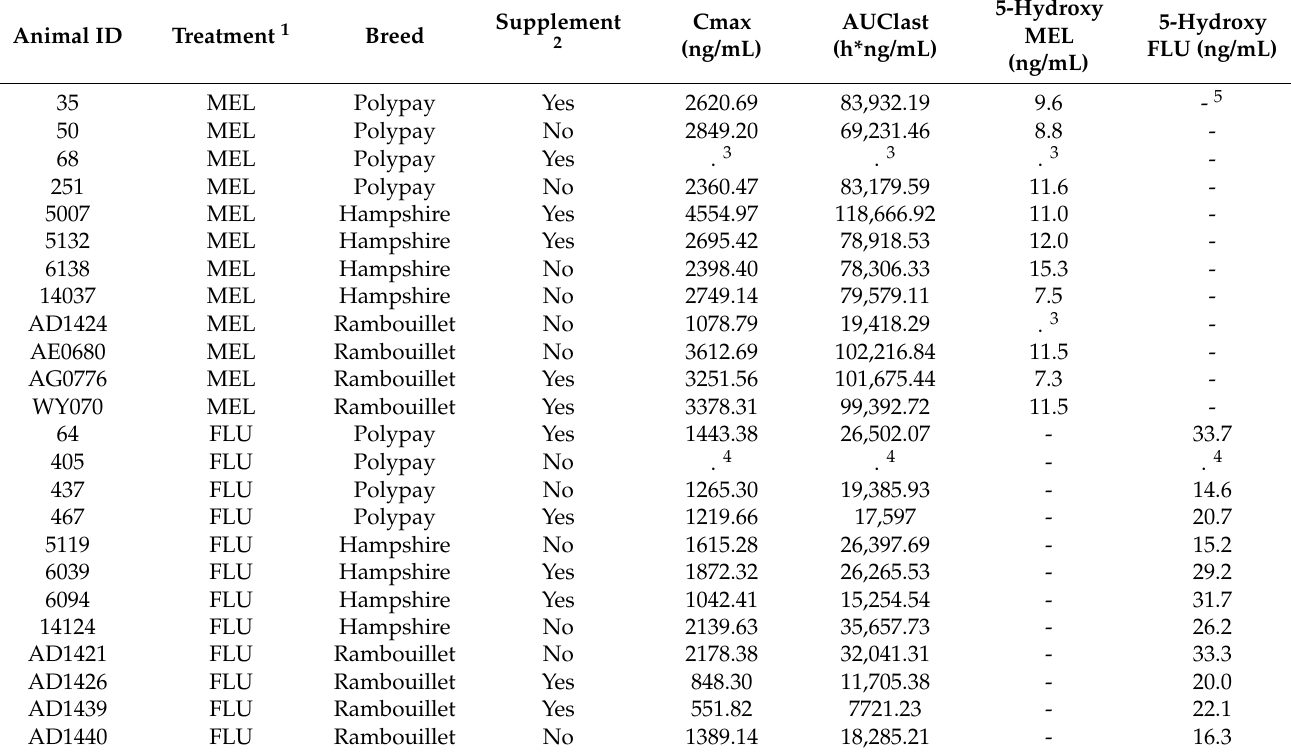
Table 5. Individual ewe pharmacokinetic results. Cmax and AUClast results represent the mean values of data collected at three post-surgical time points (24, 30, and 48 h). 5-Hydroxy MEL and 5-hydroxy FLU represent the mean metabolized residue of meloxicam and flunixin,